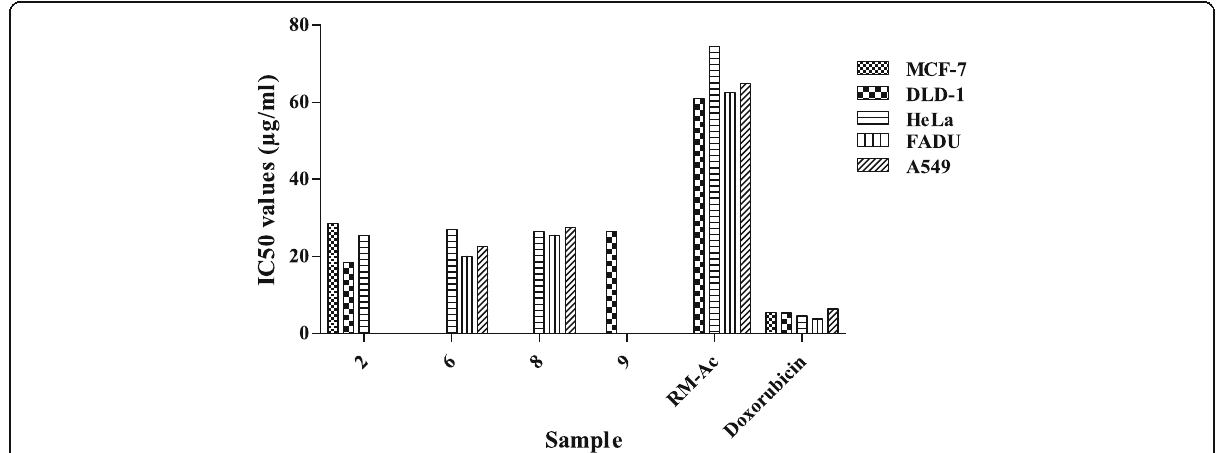
Fig. 5 IC 50 values of acetone extract and all compounds of Roccella montagnei against panel of cancer cell